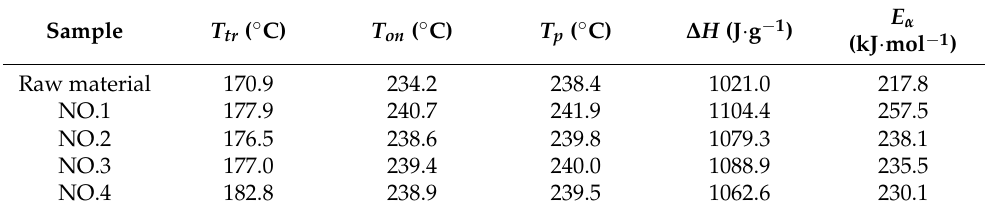
Table 4. Thermal decomposition characteristic parameters of composite particles at a heating rate of 10